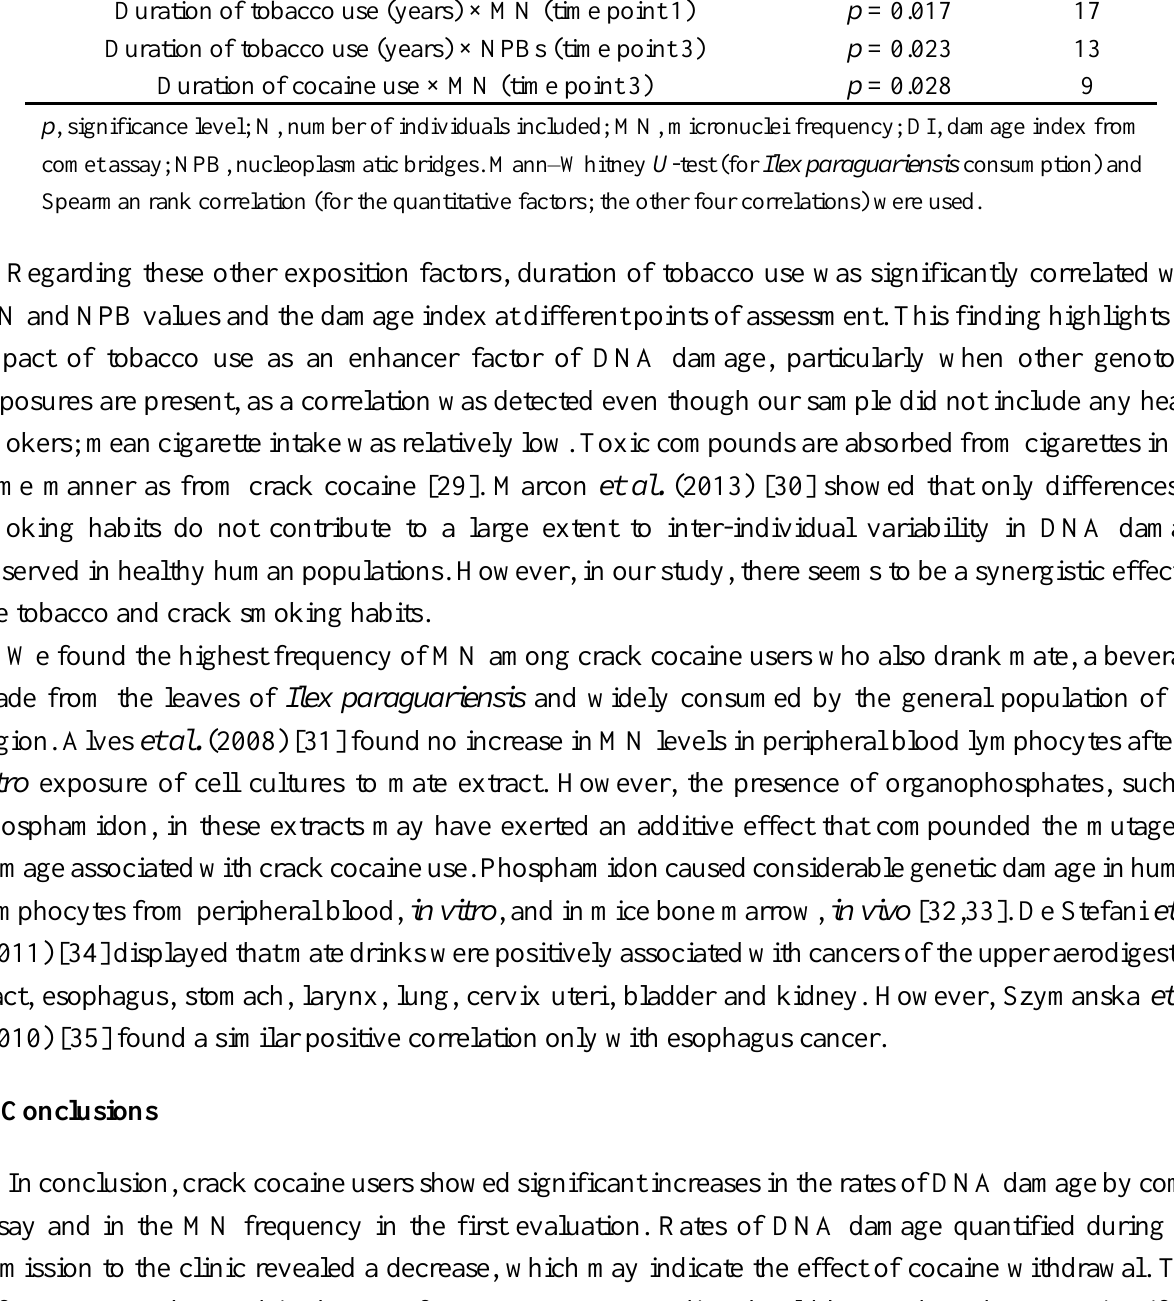
Table 3. Statistically significant correlations between nuclear changes and other factors that might have an impact on DNA damage markers. Correlation p N Ilex paraguariensis infusion × MN (time point 1) p = 0.045 13 Duration of tobacco use (years) × DI (time point 2) p = 0.043 19 Duration of tobacco use (years) × MN (time point 1) p = 0.017 17 Duration of tobacco use (years) × NPBs (time point 3) p = 0.023 13 Duration of cocaine use × MN (time point 3) p = 0.028